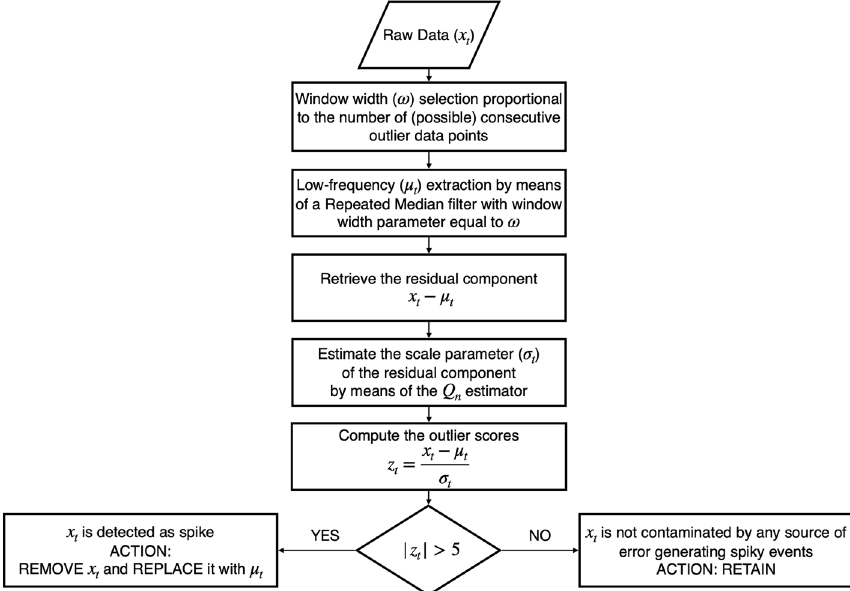
Figure 1. Flowchart of the proposed despiking